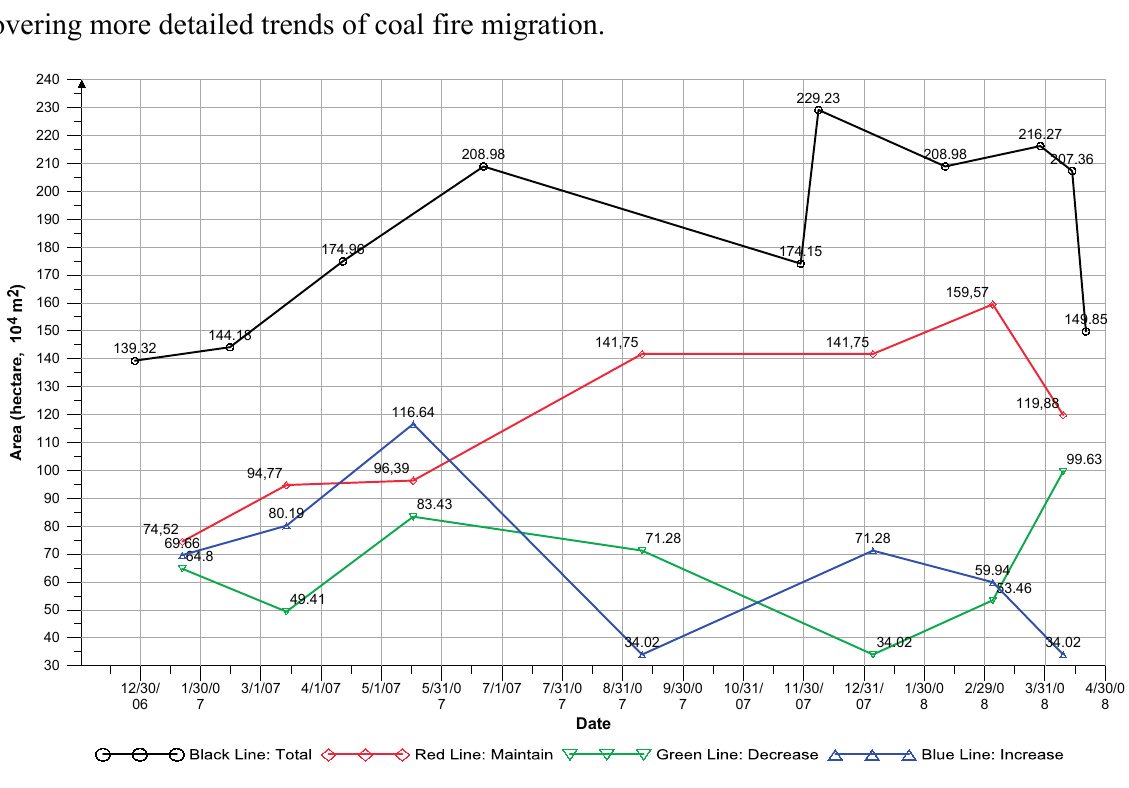
Figure 3. Increasing, decreasing and stable areas of burning in the study period from 28 December 2006 to 21 April